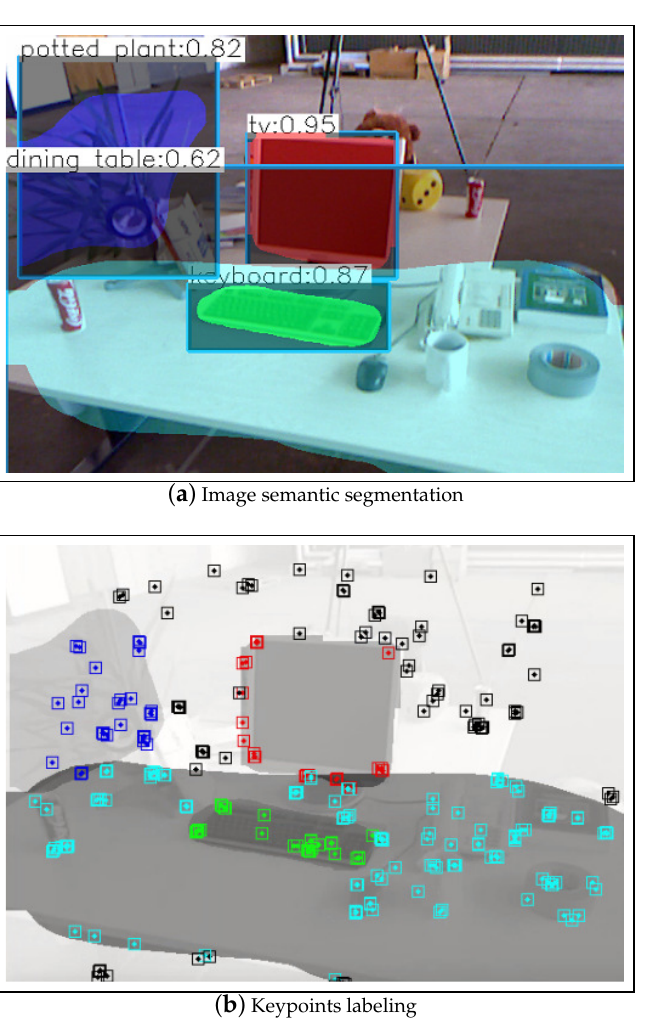
Figure 3. Object modeling (image from TUM dataset). The result of semantic segmentation masks from mask R-CNN [27] ( a ), and labeling the ORB keypoints based on the semantic information ( b ).